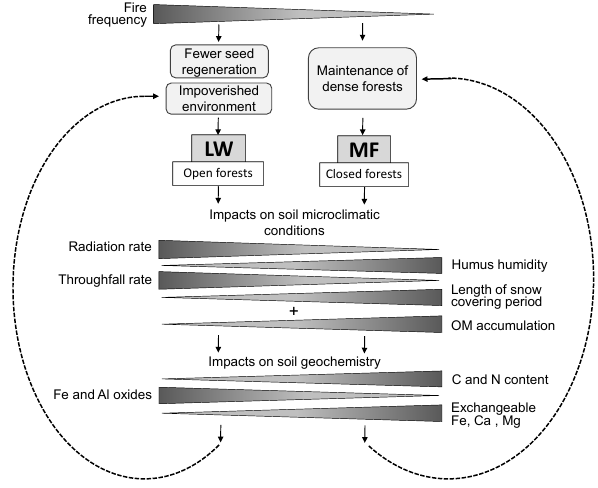
Figure 9. Schematic illustration of feedback processes between stand biomass (basal area and/or density) and soil biogeochemistry as a consequence of climatic conditions based on the present study